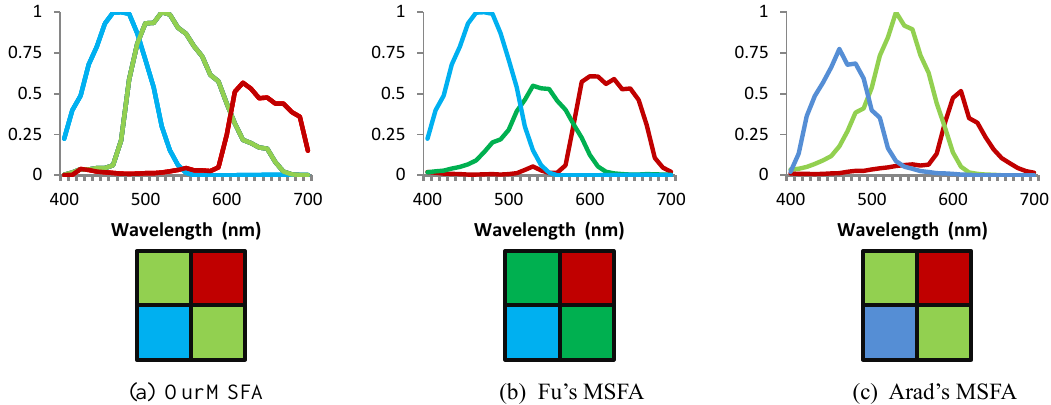
Figure 7. The spectral sensitivity functions and channel spatial arrangement of three MSFAs designed by Arad’s, Fu’s and our